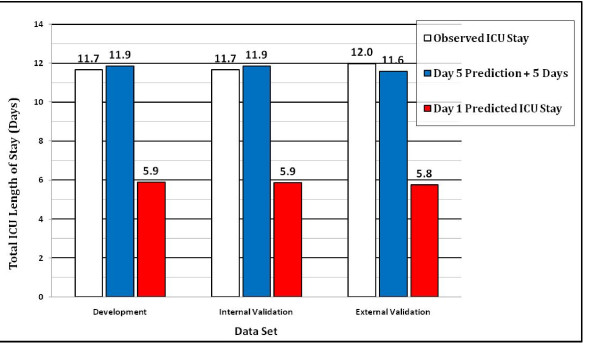
Comparison of observed and predicted intensive care unit (ICU) length of stay. Mean observed (ICU) length of stay (white bar), mean predicted length of stay based on the day 5 model [5 days + predicted remaining length of stay after day 5] (gray bar), and mean predicted length of stay based on day 1 model (black bar).